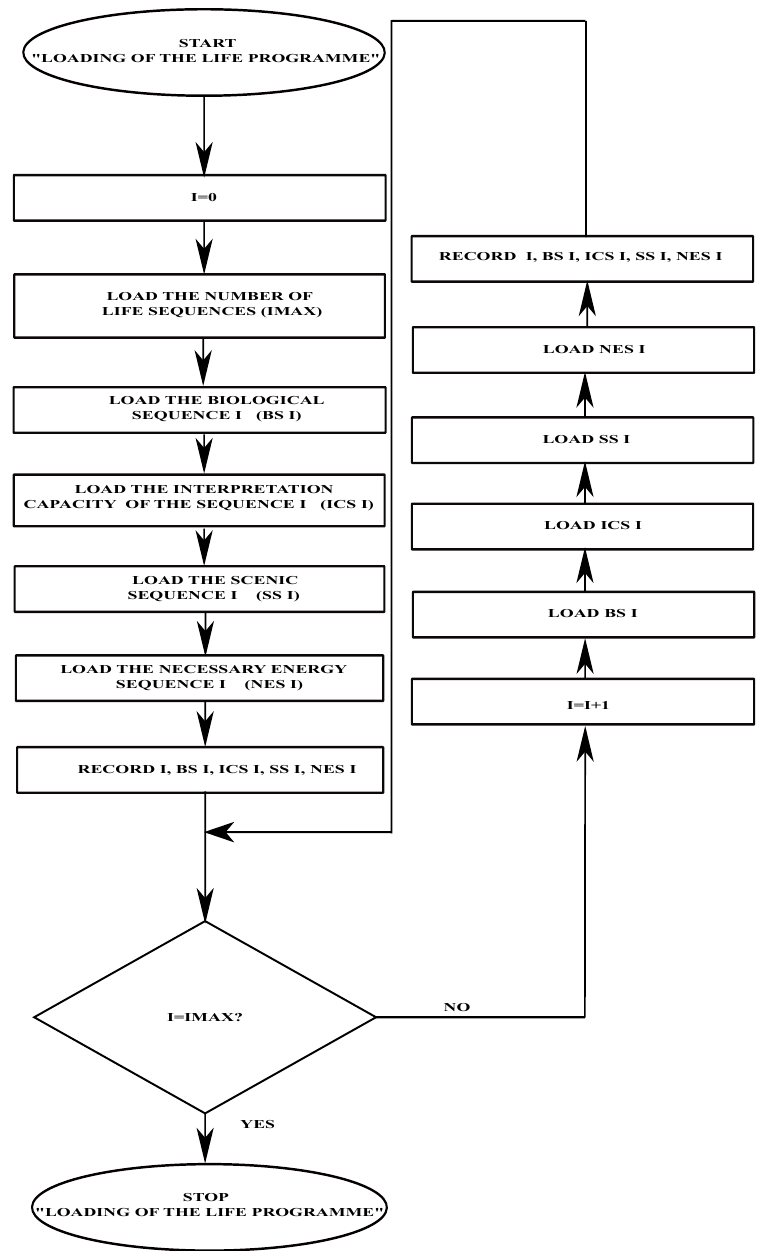
Figure 3. Loading of the life